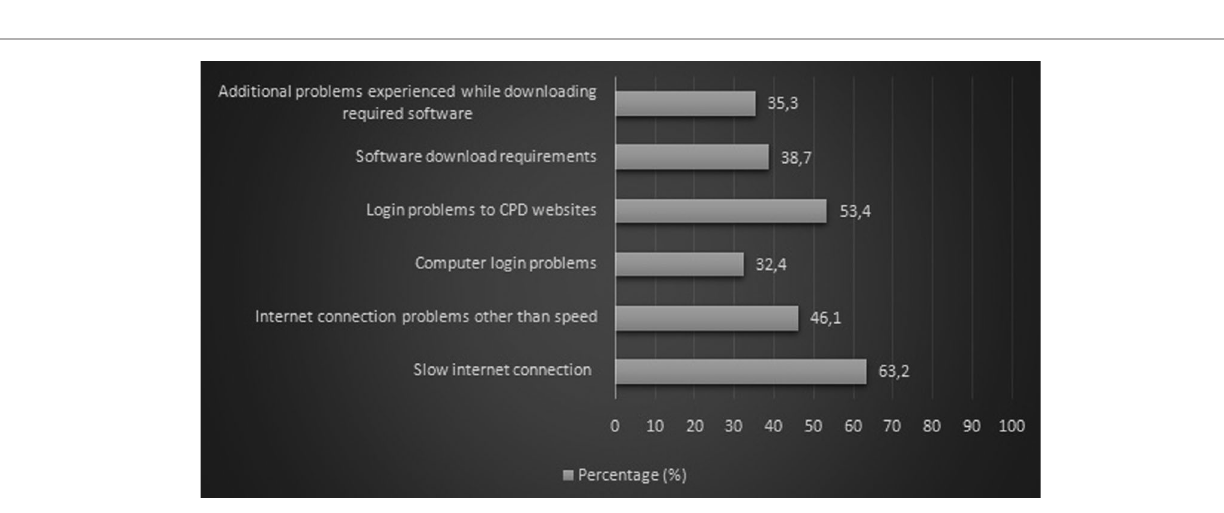
FIGURE 2 | The perceived obstacles to internet resource